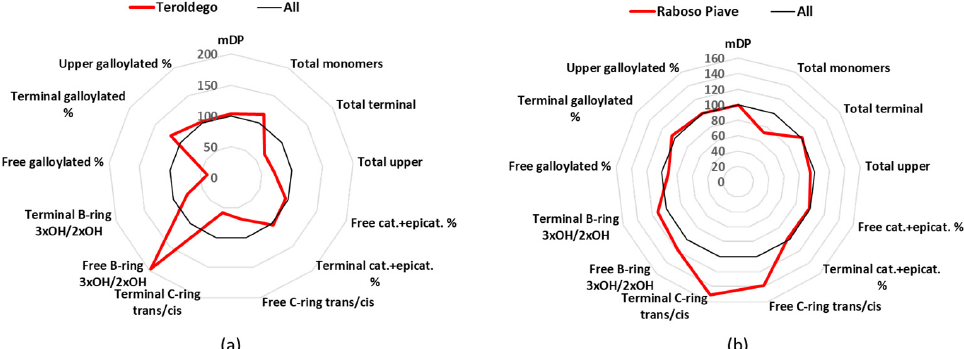
Figure 8. Radar graph comparing the percentage of the relative mean values of Teroldego ( a ) and Raboso Piave ( b ), with the mean values of the 12 groups considered as 100%. cat.: catechin, epicat: epicatechin.